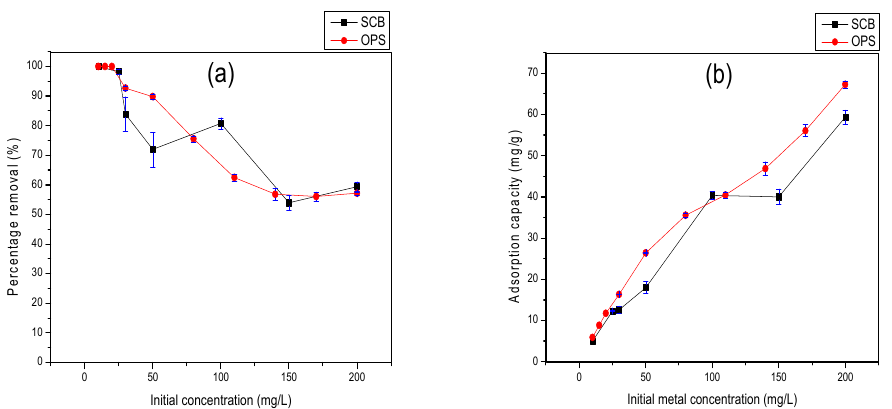
Figure 13. Effect of initial metal ion concentration: ( a ) Pb(II) percentage removal and ( b ) Pb(II) adsorption capacity.